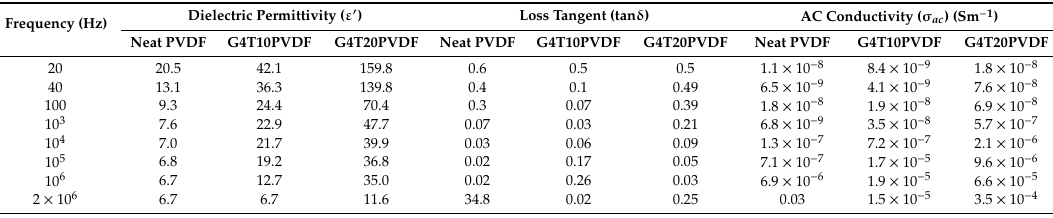
Figure 5. ( a ) Loss tangent (tan δ ) ( b ) Real part of permittivity of neat PVDF and G/TiO 2 /PVDF nanocomposites films with different graphene fraction ( c ) Loss tangent (tan δ ) ( d ) Real part of permittivity of G/TiO 2 /PVDF nanocomposites films with different TiO 2 fraction. Table 1. Dielectric permittivity ( ε′ ), loss tangent (tan δ ) and AC conductivity ( σ ac ) of neat PVDF, G4T10PVDF and G4T20PVDF.